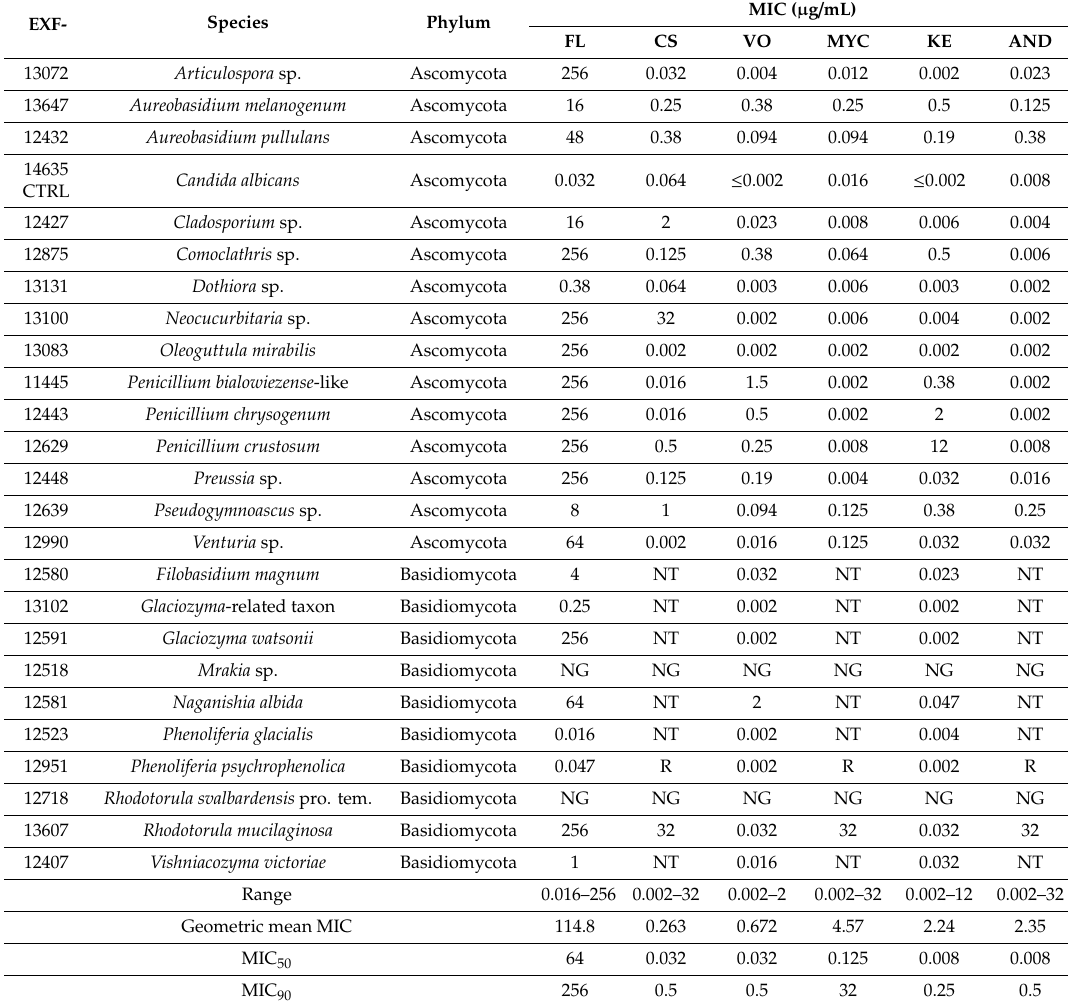
Table 3. Etest MIC (minimum inhibitory concentration) results for the fungal species tested. MIC values are reported in µ g / mL. FL: Fluconazole; CS: Caspofungin; VO: Voriconazole; MYC: Micafungin; KE: Ketoconazole; AND: Anidulafungin. NG: no growth; NT: not tested (assumed to be intrinsically